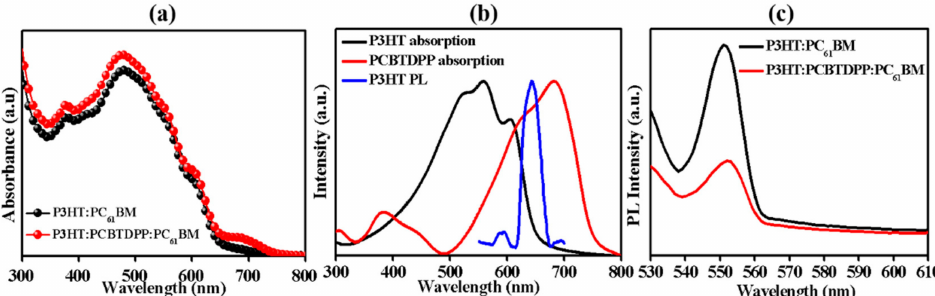
Figure 2. ( a ) UV-vis absorption of P3HT:PC 61 BM and P3HT:PCBTDPP(0.2 wt.%):PC 61 BM, ( b ) normalized absorption of as-casted P3HT and PCBTDPP and the PL of the P3HT, and ( c ) PL of P3HT:PC 61 BM and P3HT:PCBTDPP(0.2 wt.%):PC 61 BM thin